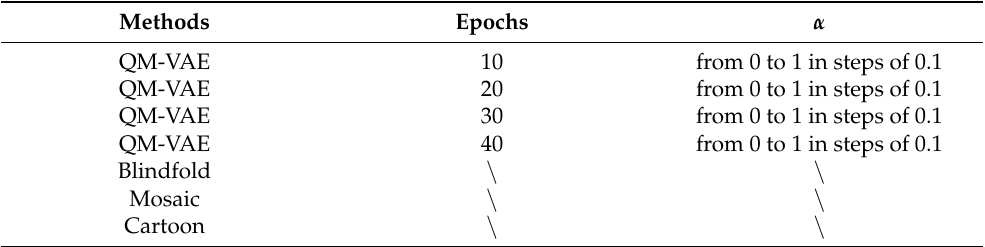
Figure 4. The distribution of the dataset. Table 1. The simulation